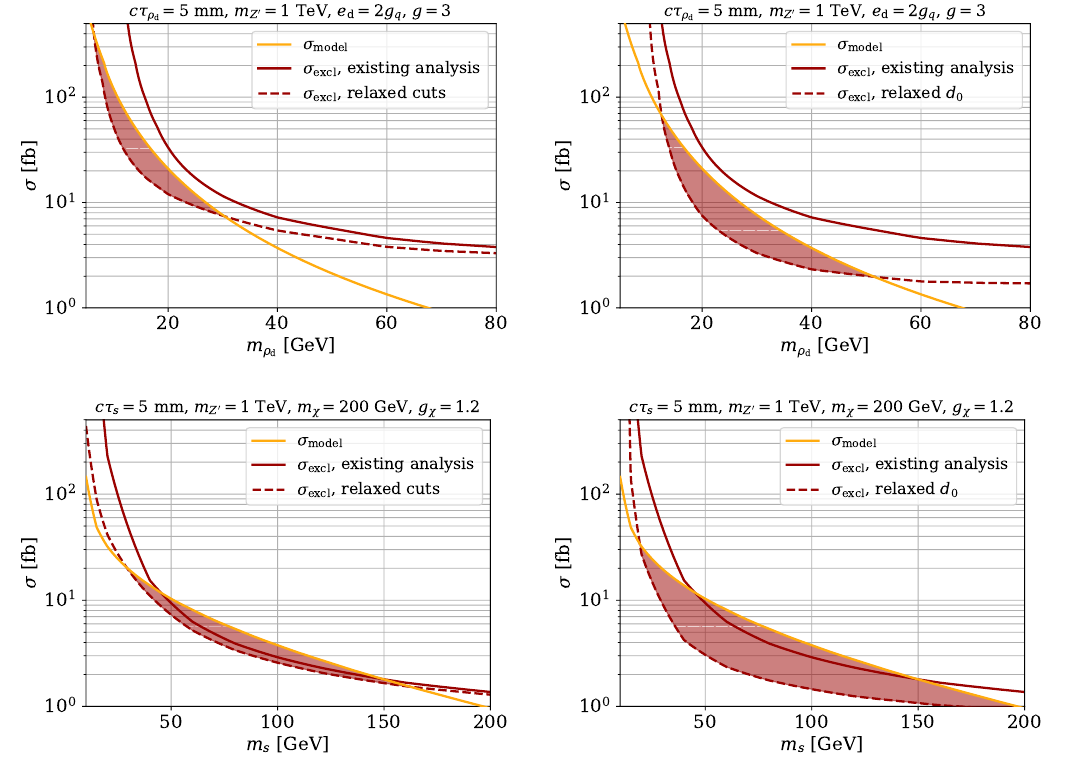
Figure 7 . Dark shower (top) and dark Higgs (bottom) production cross section in our model compared to the exclusion limit on the cross section from the existing search as well as the ‘relaxed cuts’ analysis (left) and the ‘relaxed d 0 ’ analysis (right) at 32 . 8 fb − 1 . The LLP lifetime is set to a fixed value, leading to an indirect dependence of the model cross section on the LLP